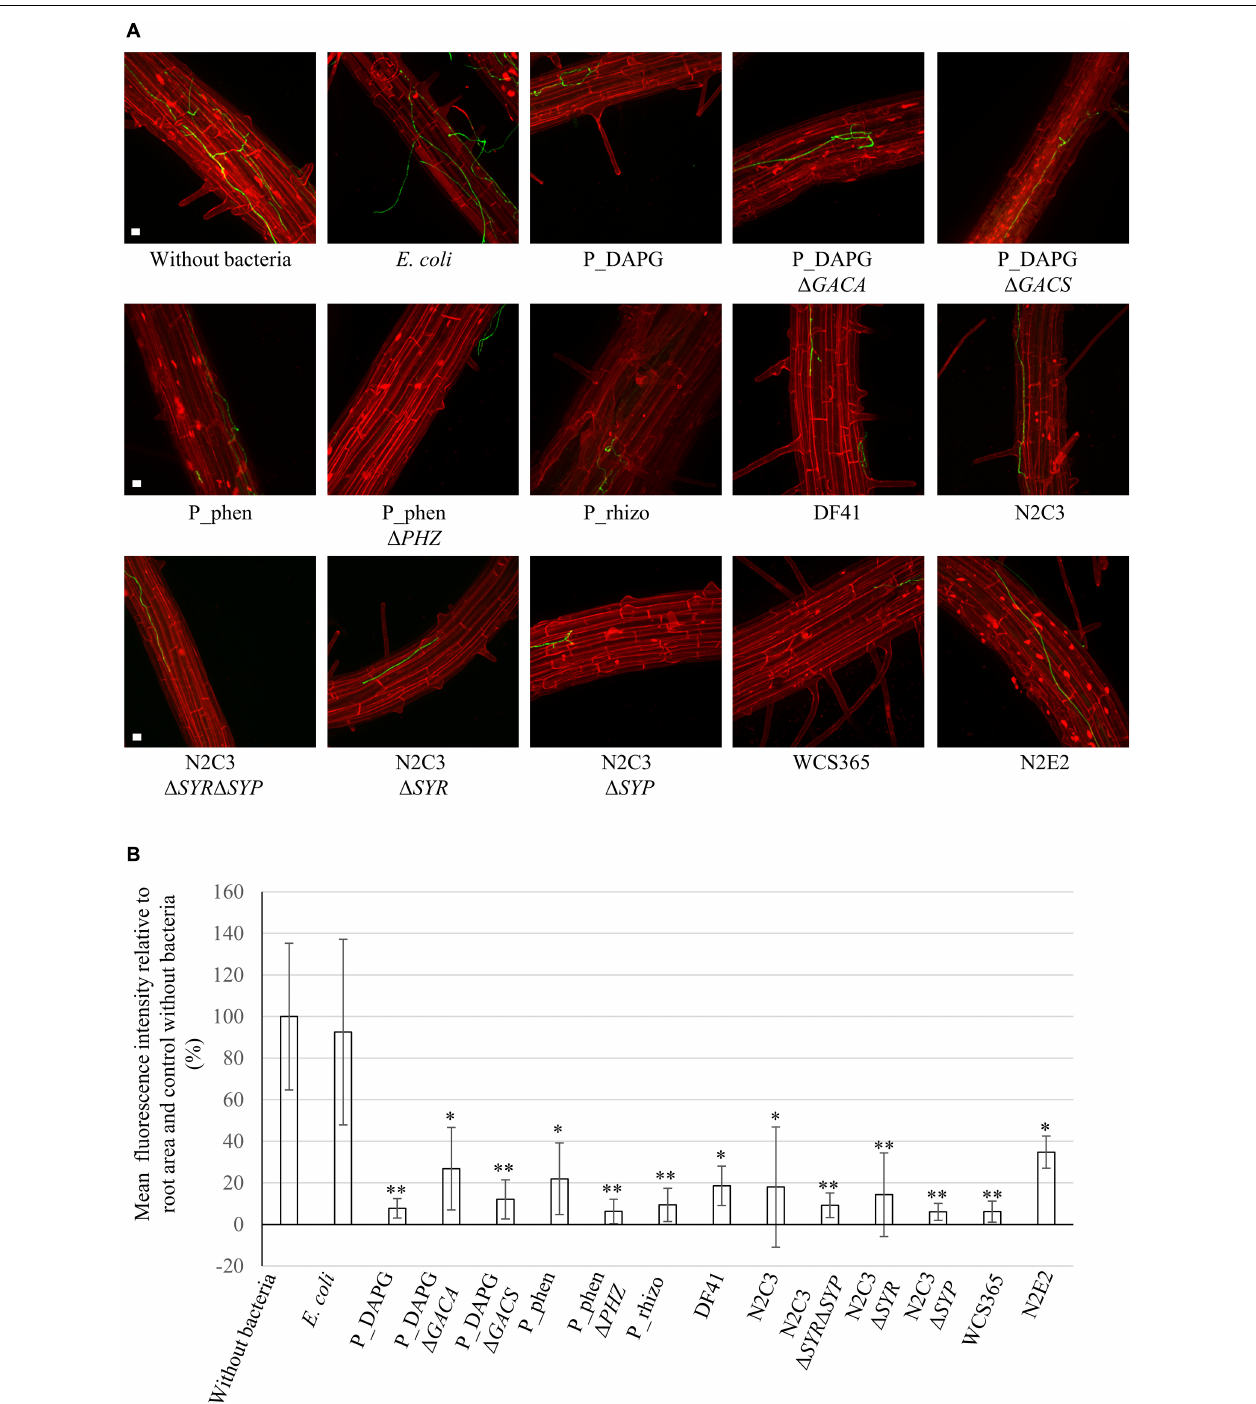
FIGURE 3 | Verticillium dahliae avoids efficient colonization of Arabidopsis thaliana roots in the presence of Pseudomona s strains. A. thaliana seedlings were pre-grown on plate and roots were coated with water (without bacteria) or a bacterial suspension of the indicated strains (OD 600 nm = 0.001). Two days later, plants were infected by root dipping in spore suspension of V. dahliae JR2 expressing GFP . After five days, fungal colonization of the root surface was investigated by fluorescence microscopy. Roots were stained with propidium iodide. Data are derived from three to four independent experiments. Per experiment, fungal colonization of two roots was analyzed for each individual treatment. For each root 10-15 stacks of single micrographs from randomly chosen root sections were pictured and projections created. (A) Single projection pictures generated from stacks of micrographs for each treatment. Roots of the control without bacteria or with E. coli were colonized by fungal hyphae. When Pseudomonas strains were applied to the roots prior to infection, large parts of the roots remained free of fungus or showed only mild colonization. The pictures show examples of fungal hyphae, which were detected on the root surface. Scale bars: 20 µ m. (B)